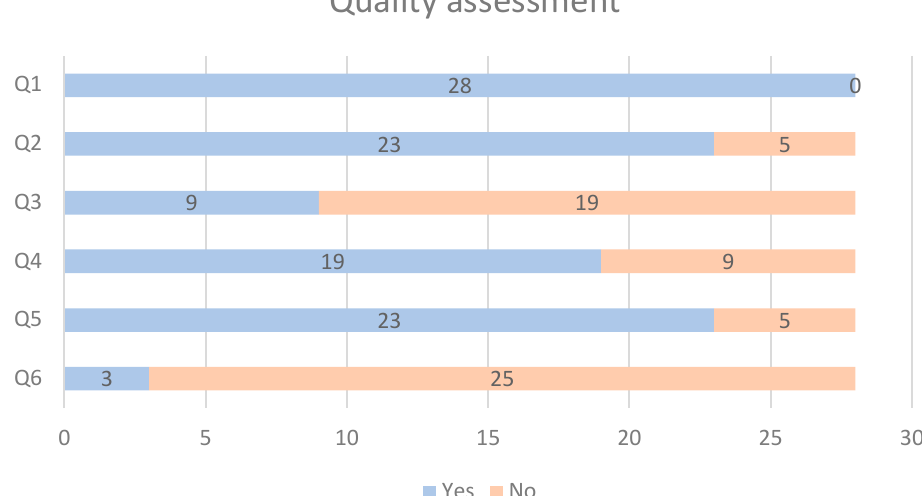
Figure 4. Results of the quality assessment of the included articles.